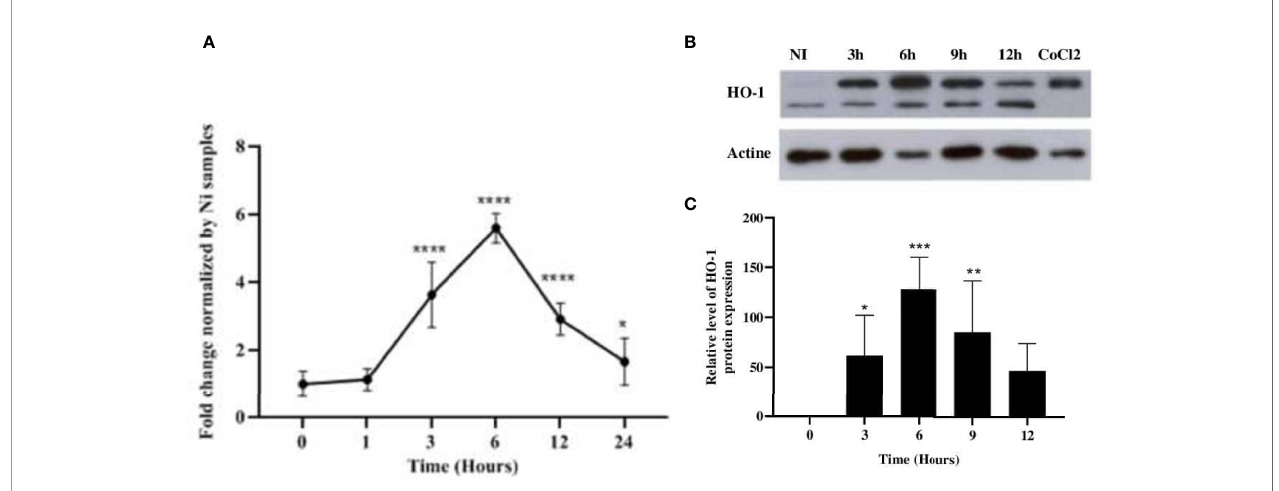
FIGURE 1 | Leishmania major induced the expression of HO-1 at both the mRNA and protein levels. Balb/c bone marrow-derived macrophages (BMdMs) and/or Raw264.7 cells were infected for the indicated time periods with L. major promastigotes. (A) The extracted mRNAs were used to perform RT-PCR. (B) The expression of heme oxygenase 1 (HO-1) was evaluated at the protein level by immunoblotting. CoCl 2 stimulation (250 ng/ml) for 3h was used as control. (C) Densitometric quanti fi cation of HO-1 protein levels using ImageJ. All data are expressed as the mean ± SD from three independent experiments. Statistical signi fi cance was placed at p < 0.05. * p < 0.05, ** p < 0.01, *** p < 0.001, **** p < 0.0001 vs . non-stimulated cells (two-way